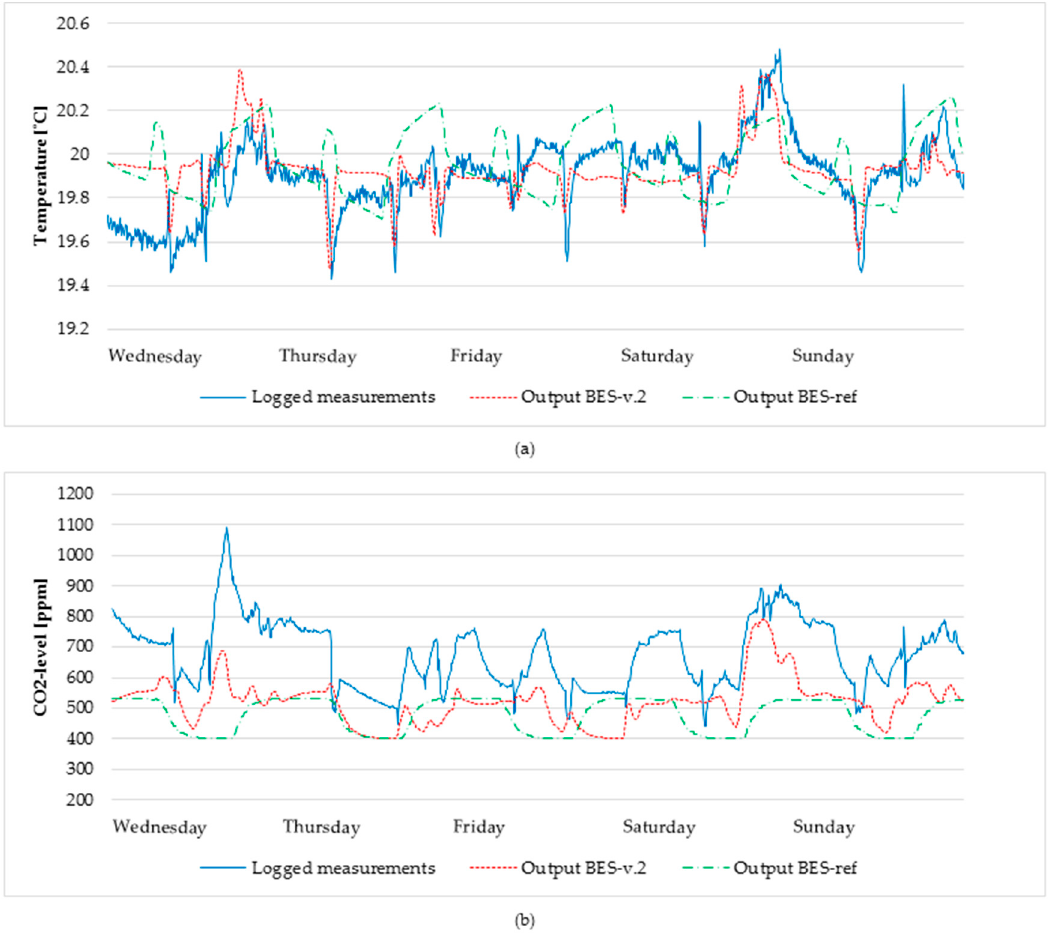
Figure 3. Logged measurements compared to simulated output from apartment 5 on the second floor, for both reference building energy simulation (BES-ref) and building energy simulation version 2 (BES-v.2), from Wednesday 19 November to Sunday 23 November: ( a ) mean temperature; ( b ) CO 2 levels.